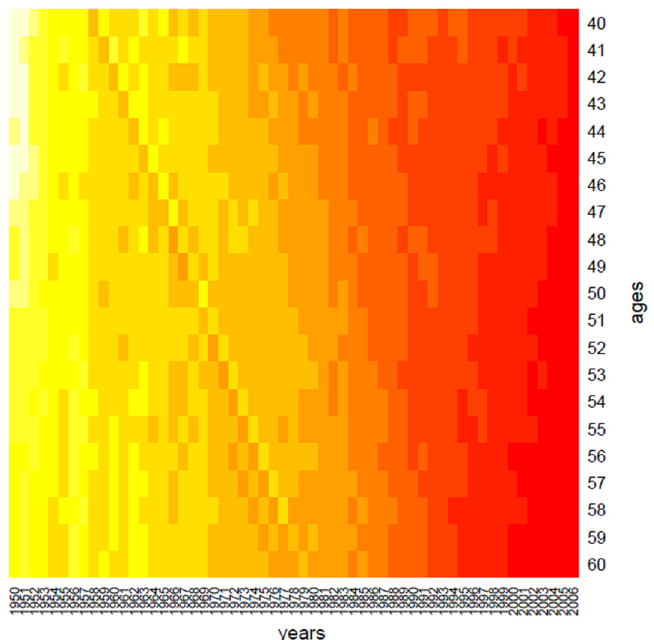
Figure 1. Clustering: the period effect.